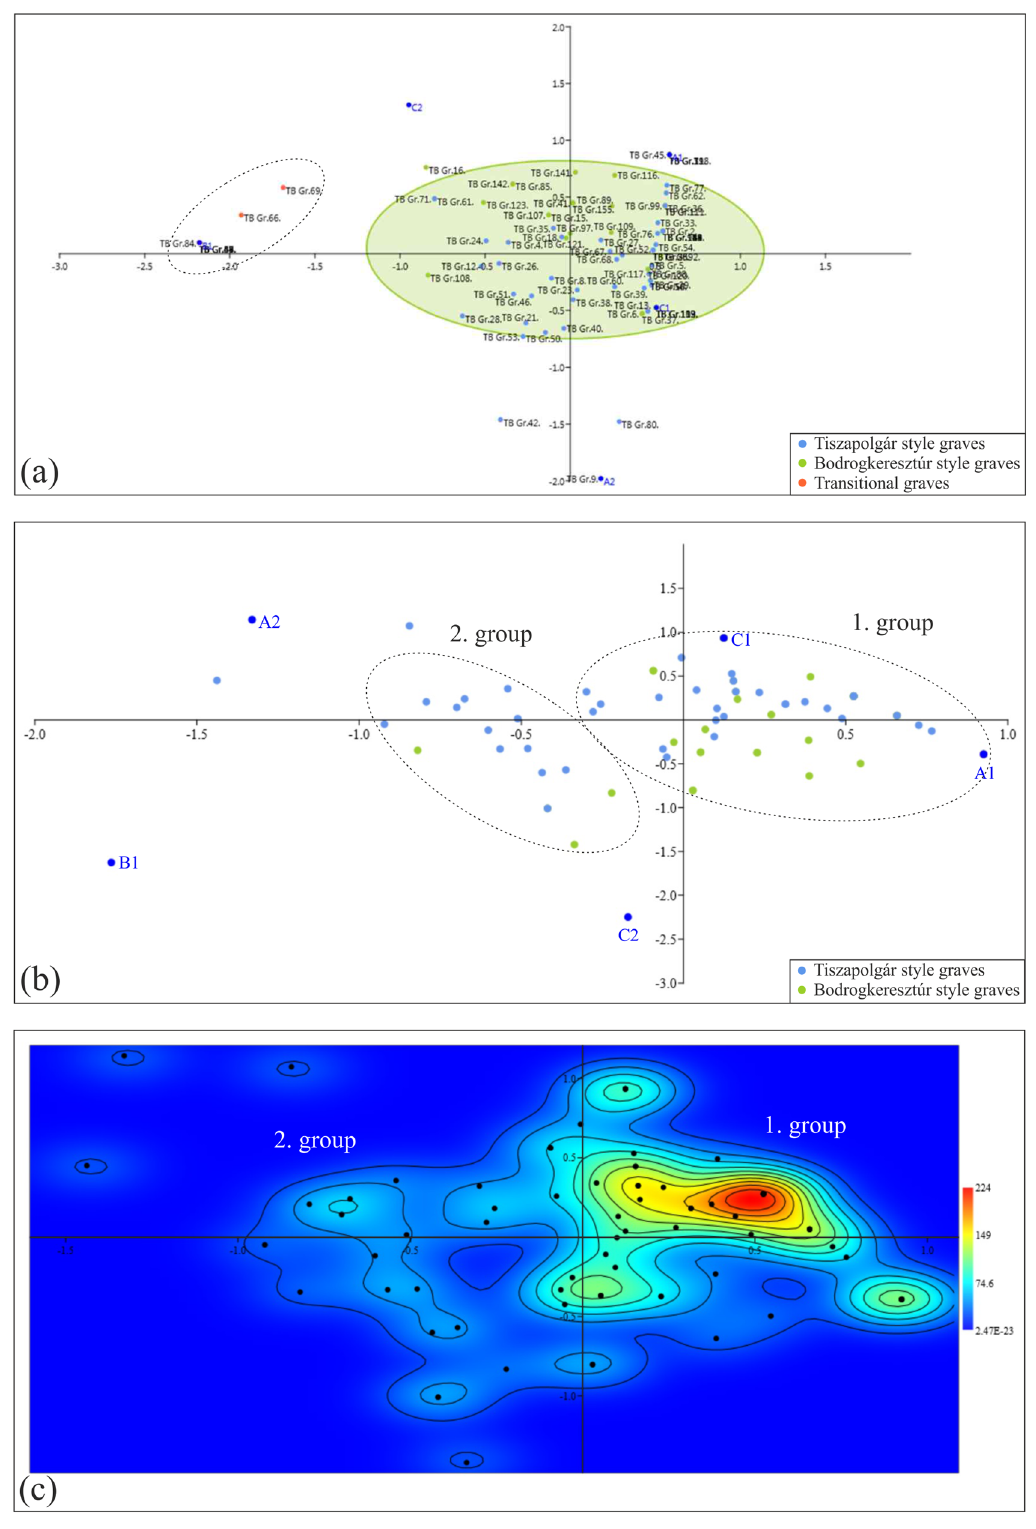
Figure 9: ( a ) Correspondence analysis of the graves from Tiszapolgár - Basatanya with 1 σ ellipse and the separation of the transitional graves. ( b ) Correspondence analysis of the graves from Tiszapolgár - Basatanya with the omission of transitional graves. ( c ) Kernel density plot generated from the second correspondence analysis from Tiszapolgár -